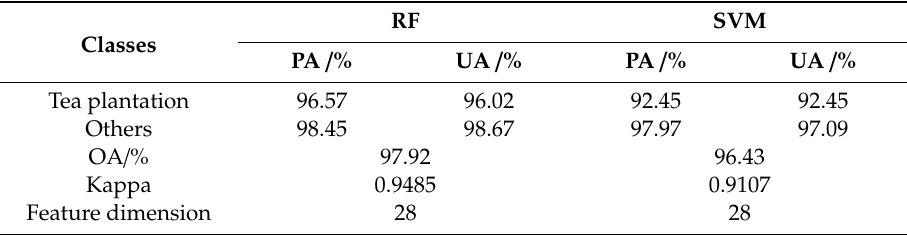
Table 5. Comparison of classification accuracies of the RF and SVM